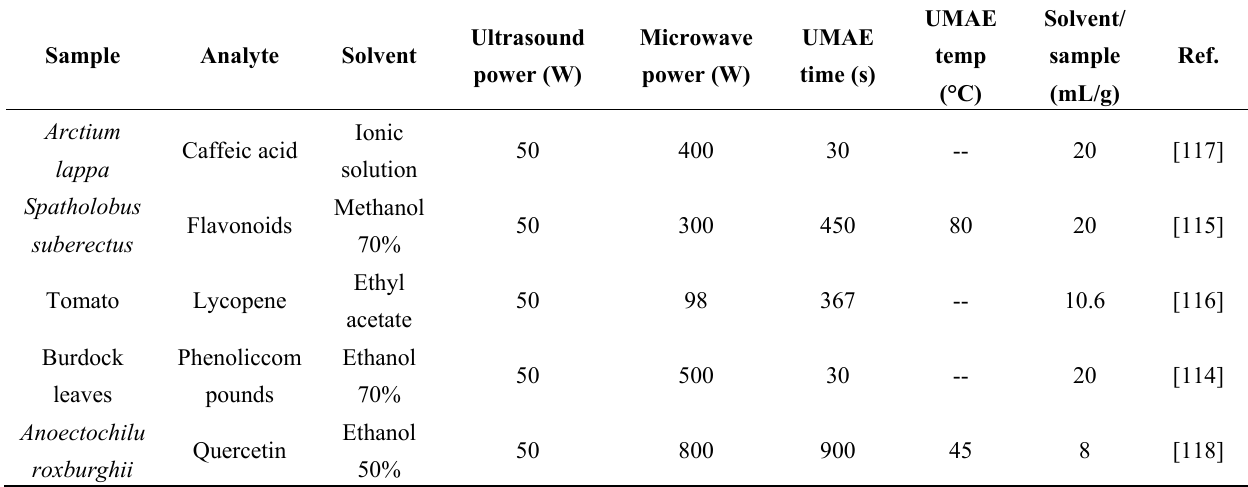
Table 4. Conditions for phenolic extraction from plant-based foods using UMAE.